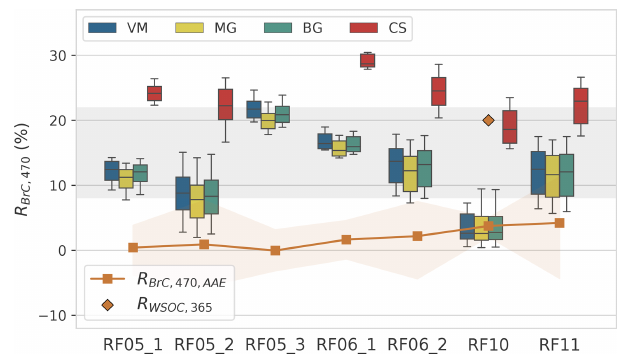
Figure 7. Contribution of BrC to the total absorption obtained from optical closure approach in this study (boxes, R BrC , 470 ) and from the AAE attribution method (orange squares, R BrC , 470 , AAE ) at 470nm. The grey zone indicates the R BrC , 470 range of 8%– 22% in this study. Orange shades of R BrC , 470 , AAE represent the 10th and 90th percentile. The orange diamond is the contribu- tion of WSOC (water-soluble organic carbon) to the total absorp- tion, R , %WSOC , 365 (Athanasios Nenes, personal communication, 2021).